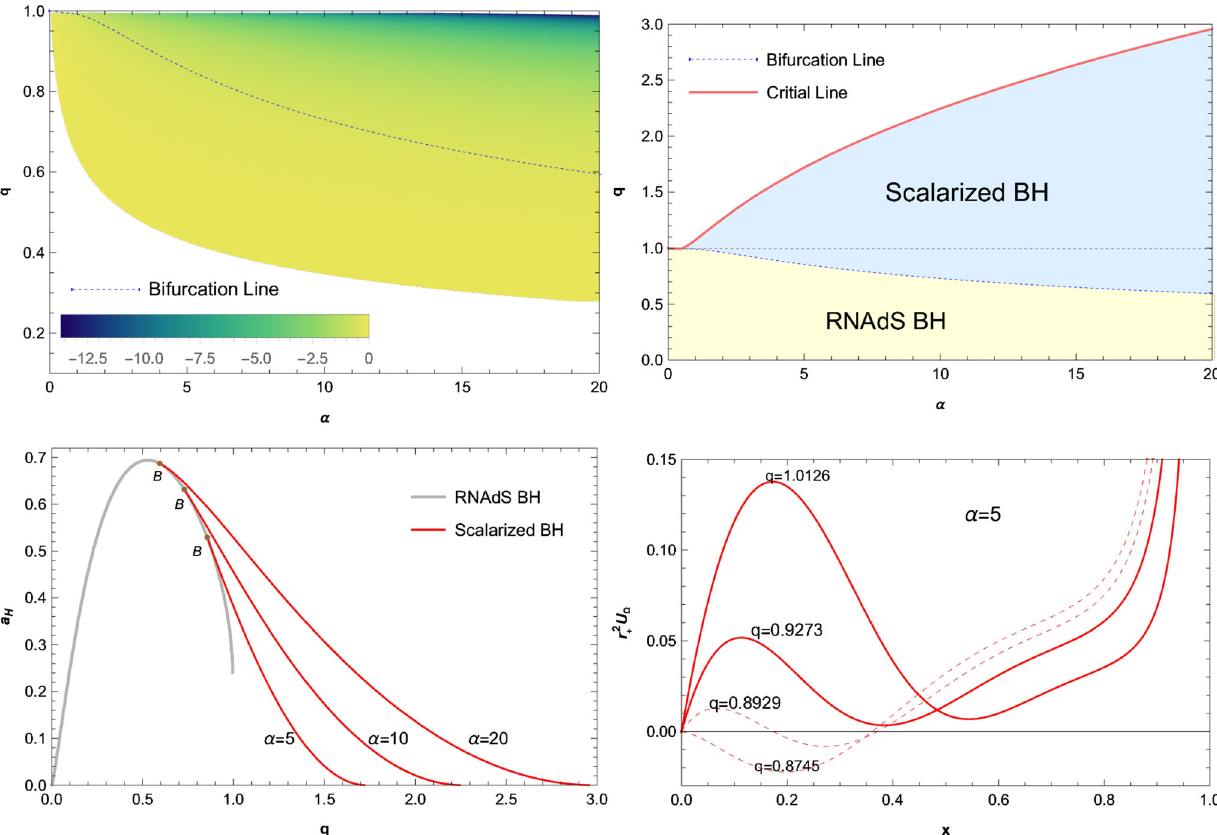
Fig. 1 Plots of tachyonically unstable region for RNAdS black holes, bifurcation lines. The critical line is depicted by a red solid line, on which the reduced horizon area a H vanishes. The horizontal dashed andthedomainofexistence,entropicpreferenceandeffectivepotentials for scalarized black holes. Here, we take Q / L = 0 . 1. Upper left: den- gray line denotes extremal RNAdS black holes, above which RNAdS (cid:9) (cid:10) black hole solutions do not exist. Lower left: reduced horizon area a H μ 2 − μ 2 Q 2 evaluated at the event horizon r = r + as sity plot of ef f BF against q for RNAdS and scalarized black holes. The scalarized black a function of q and α for the scalar perturbation in RNAdS black holes. hole solutions are always entropically preferred, which means that they < μ 2 , We only display the tachyonically unstable region, where μ 2 ef f BF are globally stable in a micro-canonical ensemble. Lower right: effec- in the α - q plane. The closer RNAdS black holes are to the extremal tive potentials of scalarized black holes with α = 5 for several values of limit, the more unstable the scalar field becomes. The blue dashed line q . Solid red lines denote positive definite effective potentials between represents the bifurcation line, where tachyonic instabilities are strong the event horizon and the spatial infinity, while dashed red lines rep- enough to induce scalarized black holes. Upper right: domain of exis- resent those possessing negative regions. When q is large enough, the tence for scalarized RNAdS black holes in the α - q plane, which is scalarized black hole solutions are stable against radial highlighted by the light blue region and bounded by the critical and